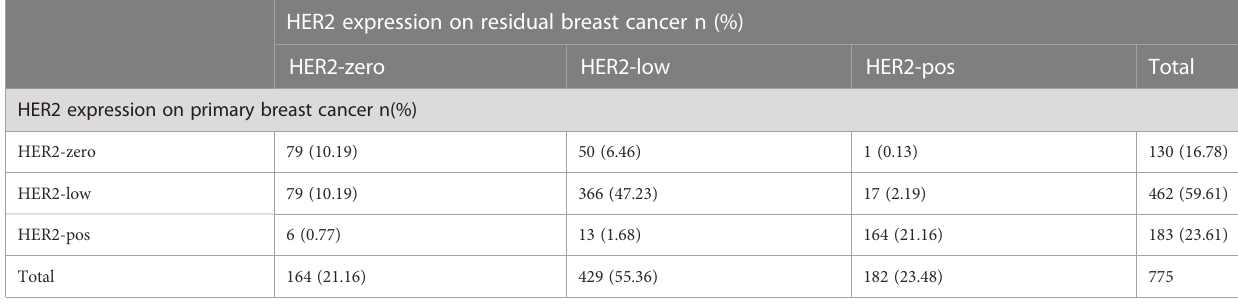
TABLE 1 HER2 expression evolution from primary breast cancer to residual breast cancer. HER2 expression on residual breast cancer n